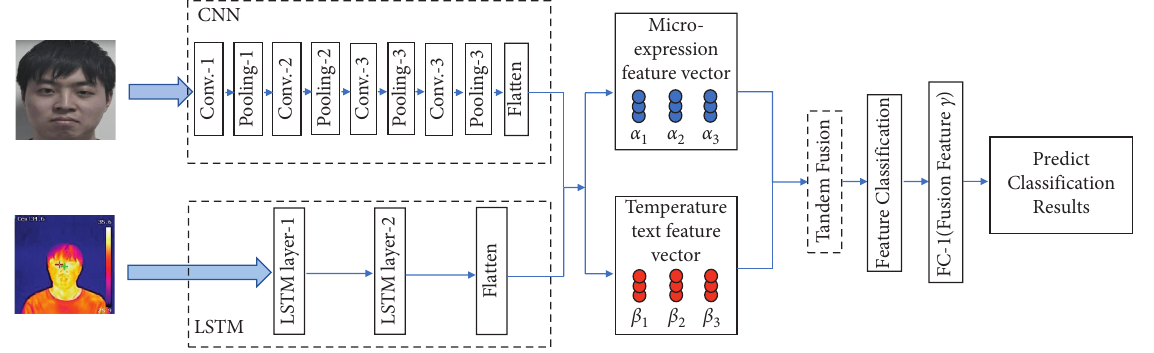
Figure 6: Multimodal recognition neural network model.